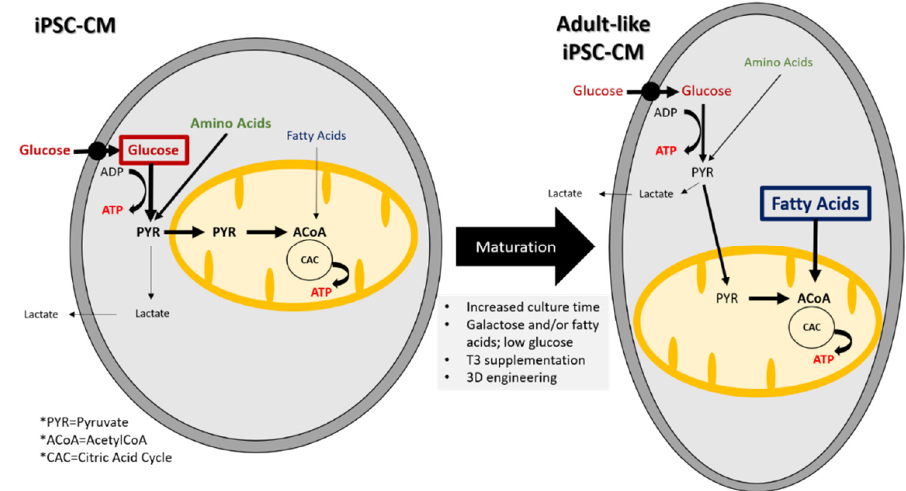
Figure 1. Substrates and metabolic pathways in iPSC-CMs and adult-like iPSC-CM. Metabolic changes are required for maturation into adult-like iPSC-CMs.